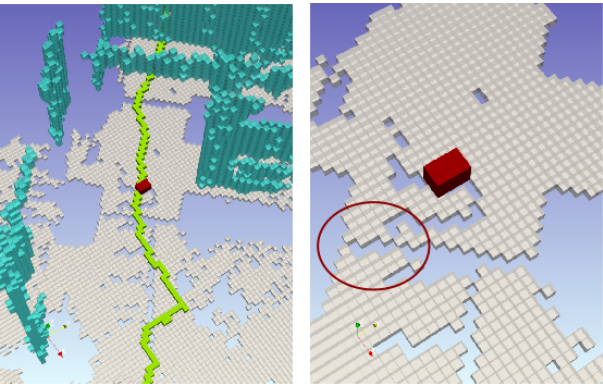
Figure 12. Door location is detected (left), but floor not separated into two indoor spaces, because touching floor voxels (right)